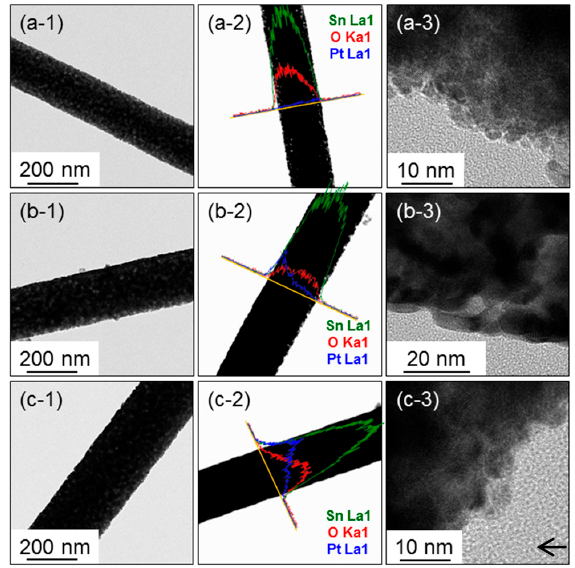
Figure 4. TEM results taken from Pt-SnO 2 Nanowires (NWs) with 3 nm-thick Pt layer: ( a-1 ) low magnification TEM image, ( a-2 ) EDS elemental line profiles, and ( a-3 ) a high-resolution TEM image; 10 nm-thick Pt layer: ( b-1 ) a low magnification TEM image, ( b-2 ) EDS elemental line profiles, and ( b-3 ) a high-resolution TEM image; 20 nm-thick Pt layer: ( c-1 ) a low magnification TEM image, ( c-2 ) EDS elemental line profiles, and ( c-3 ) a high-resolution TEM image.